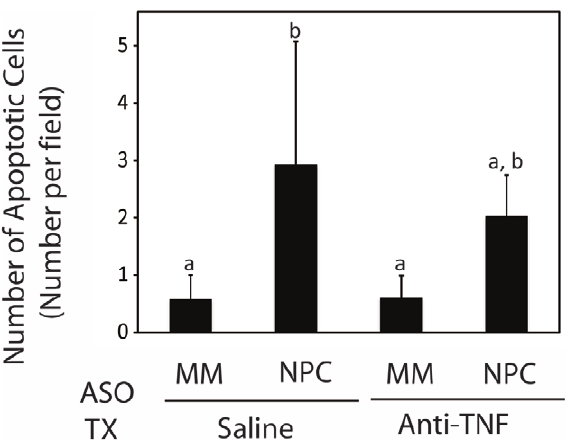
Figure 4. Effect of NPC1 knockdown and anti-TNF treatment on hepatic apoptosis. Liver sections from mice injected for 9 weeks with mismatched (MM) and NPC1-specific ASOs and subjected to treatment (TX) with saline or anti-TNF were subjected to fluorometric TUNEL staining. Apoptotic nuclei were quantified. Each bar represents the mean 6 SD number of cells per field from 5 animals in each treatment group. The lettering (a, b) shows statistically dissimilar groups. Samples with two letters represent values that are intermediate to the statistical groups and are thus not considered significantly different from either